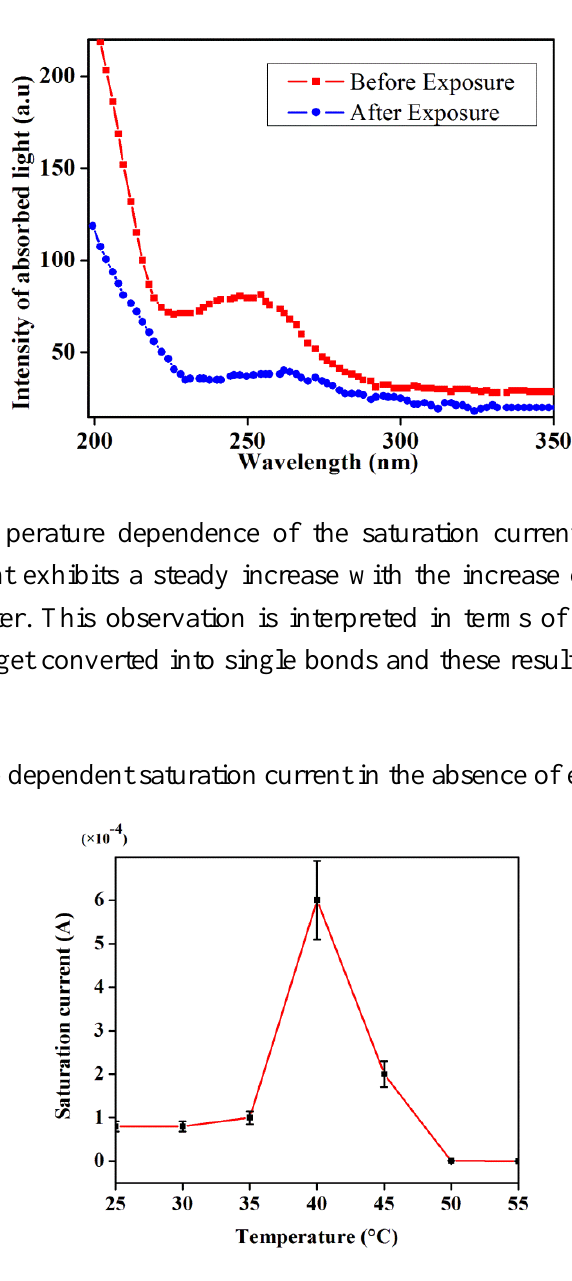
Figure 4. The UV-VIS spectrum of DNA before and after exposure to electromagnetic fields.